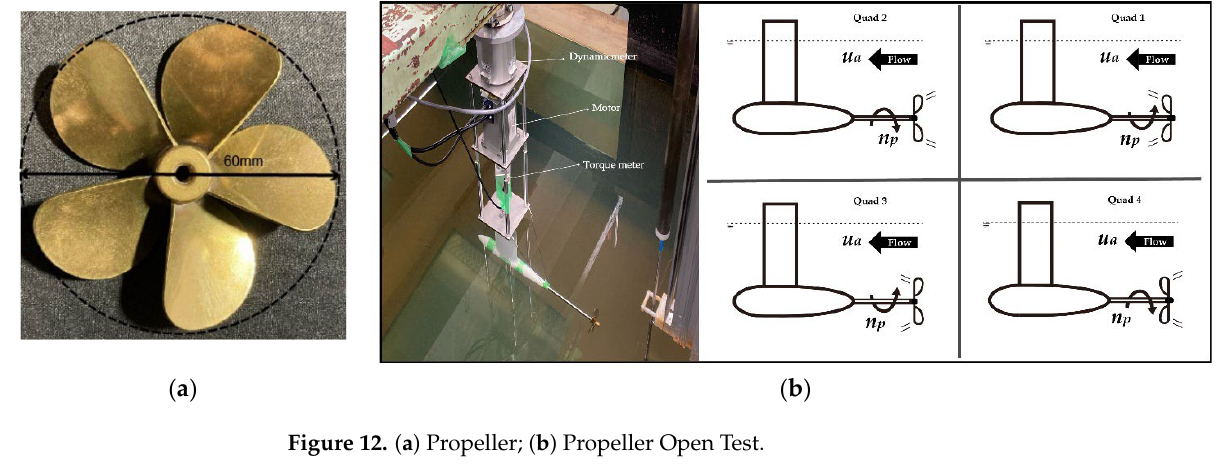
Figure 12. ( a ) Propeller; ( b ) Propeller Open Test. Table 4. Propeller Open Test conditions.